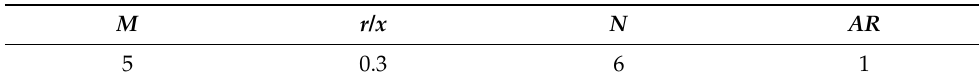
Table 4. Crack tip modeling guidelines suggested through SIF sensitivity analysis.